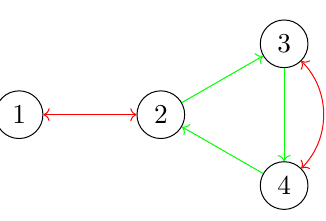
Figure 7 . The duality group action on the four vacua of the su (3) N = 1 (cid:3)